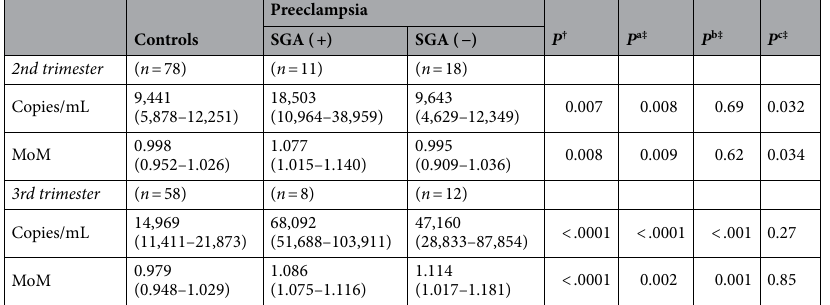
Table 4. Comparison of methylated HYP2 levels and MoM values between controls and patients with preeclampsia with or without SGA neonates. Data are given as median (interquartile range). P a , PE with SGA versus controls; P b , PE without SGA versus controls; P c , PE with SGA versus PE without SGA. MoM multiple of the median, SGA small for gestational age. † P value by the Kruskal–Wallis test. ‡ P value by the Wilcoxon rank sum test (adjusted by the step-up Bonferroni